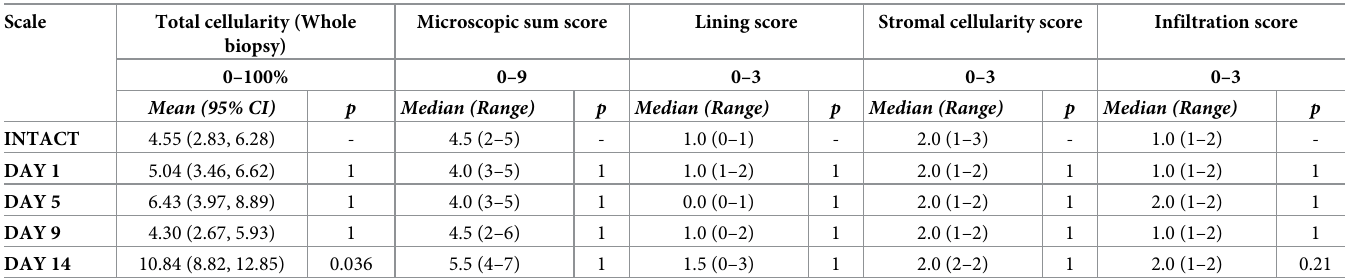
Table 3. Histopathological synovium outcomes. Scale Total cellularity (Whole